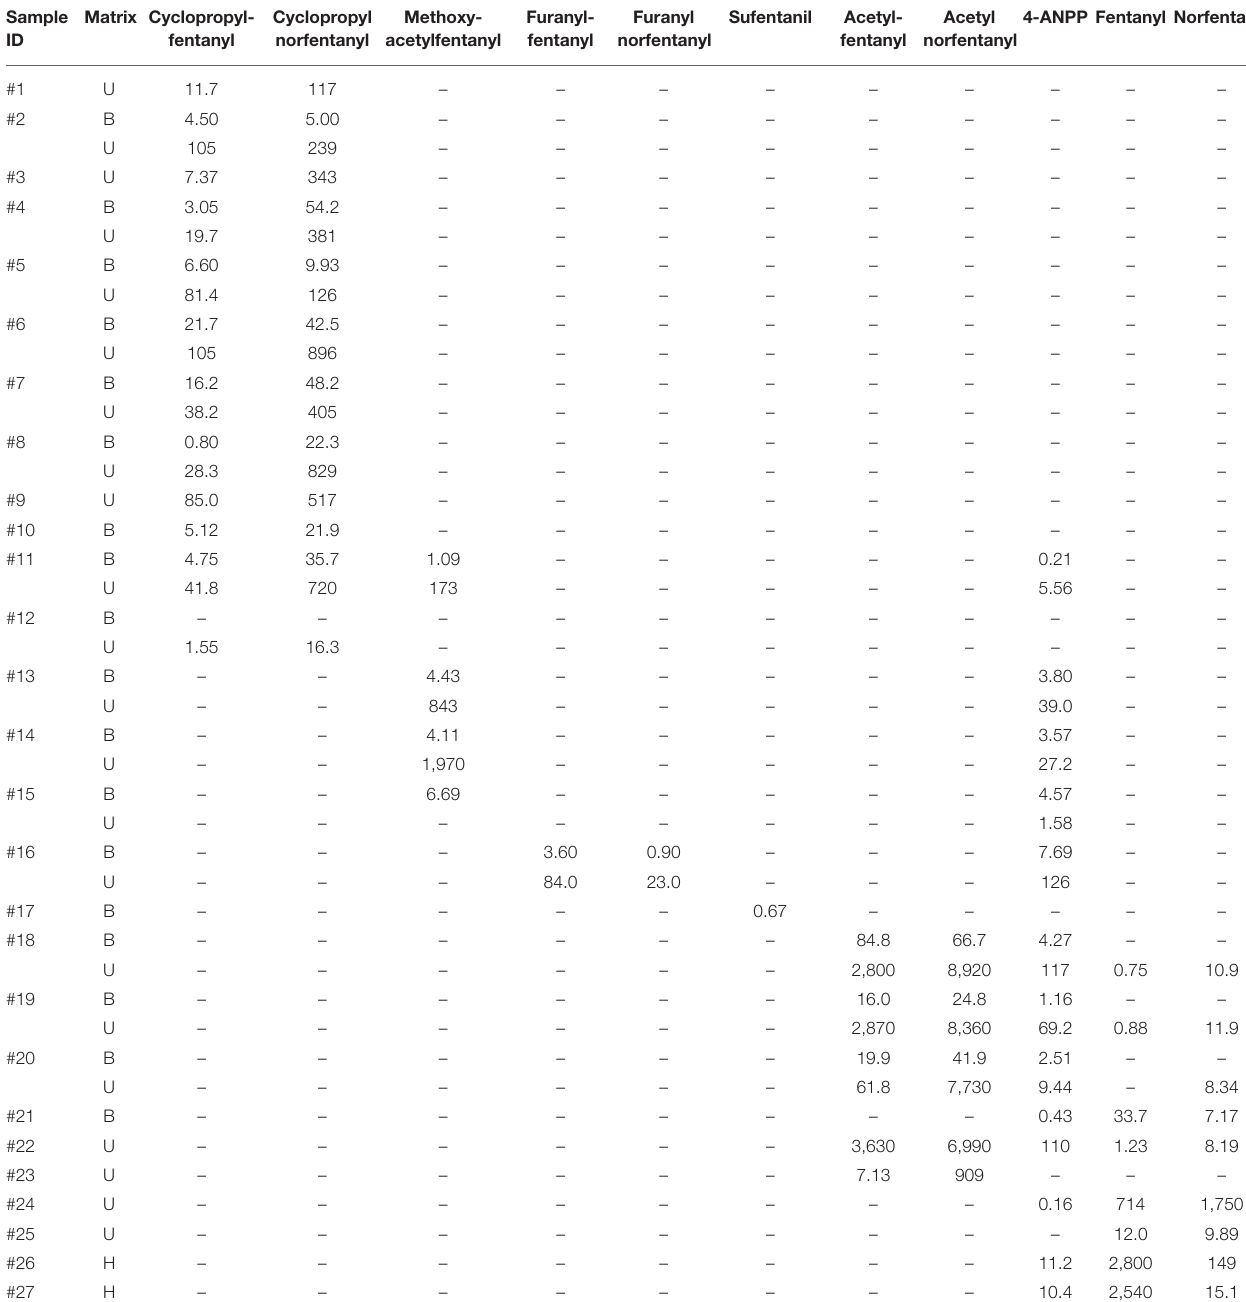
TABLE 5 | Fentanyl and analogs’ concentration measured in authentic